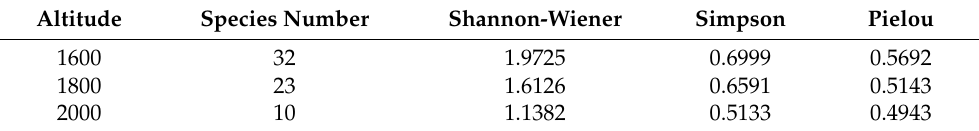
Table 7. Species diversity of tree layer in different elevation study